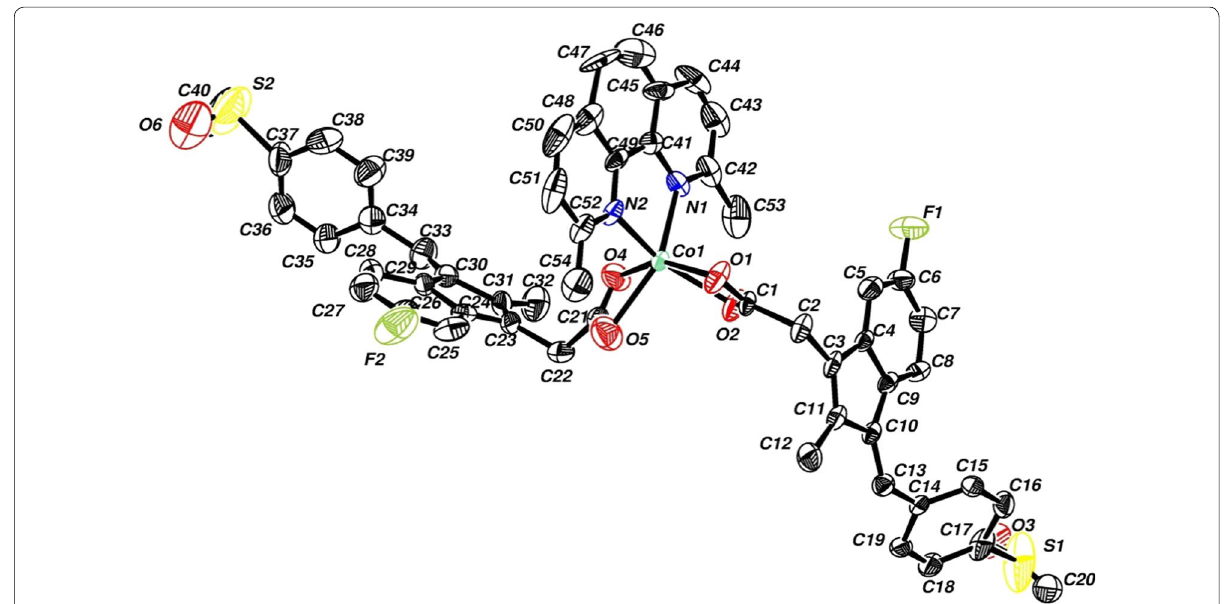
Fig. 3 The molecular structure view of 4 showing the atom labeling scheme